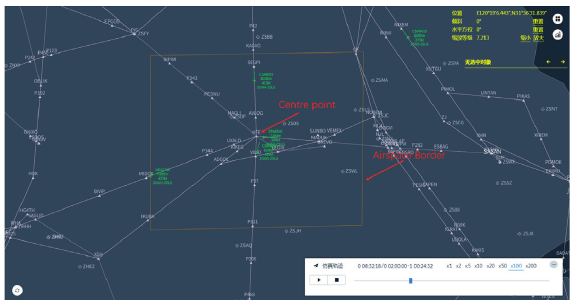
Figure 9: The scenario range shown at the interface of